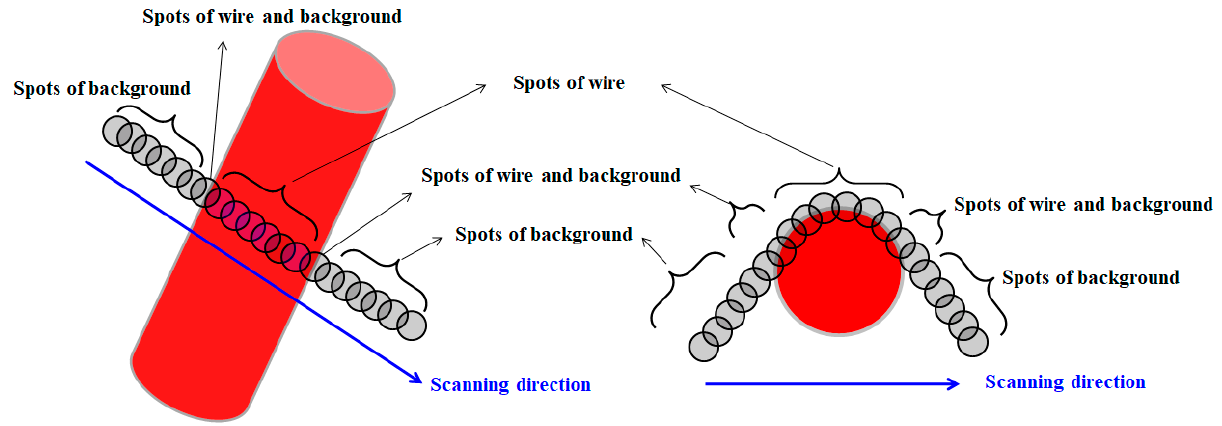
Figure 7. Schematic of temperature measuring method of wire rod using a scan-type pyrometer during Stelmor cooling.